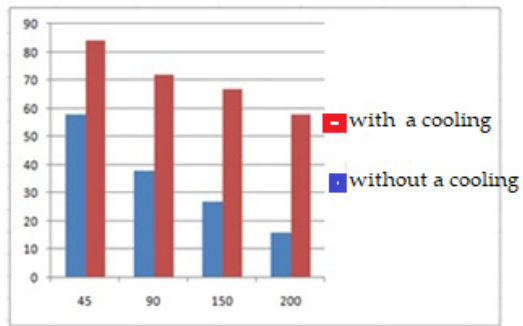
Figure 23. Efficiency with and without a cooling system .